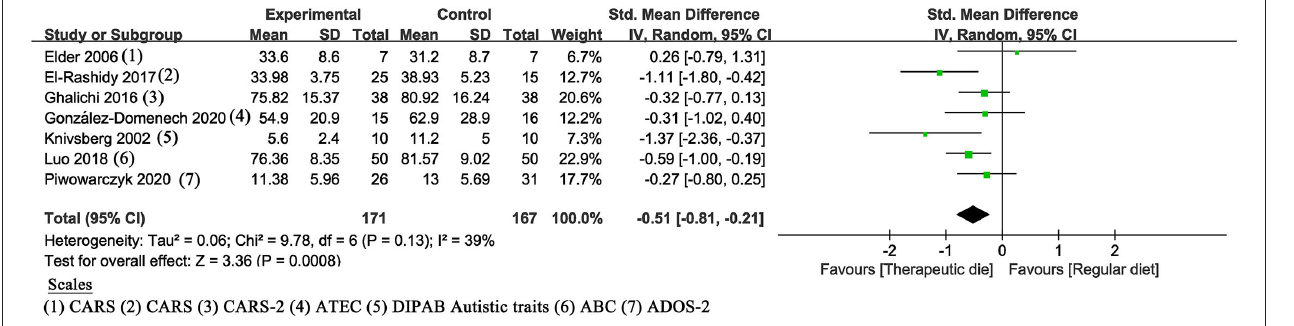
FIGURE 3 | Meta-analysis results and scales for clinician-reported core symptoms. GARS (-2), Gilliam Autism Rating Scale (Second Edition); ATEC, Autism Treatment Evaluation Checklist; DIPAB, a standardized Danish scheme to evaluate behavior; ABC, Autism children behavior checklist; ADOS-2, Autism Diagnostic Observation Schedule, Second